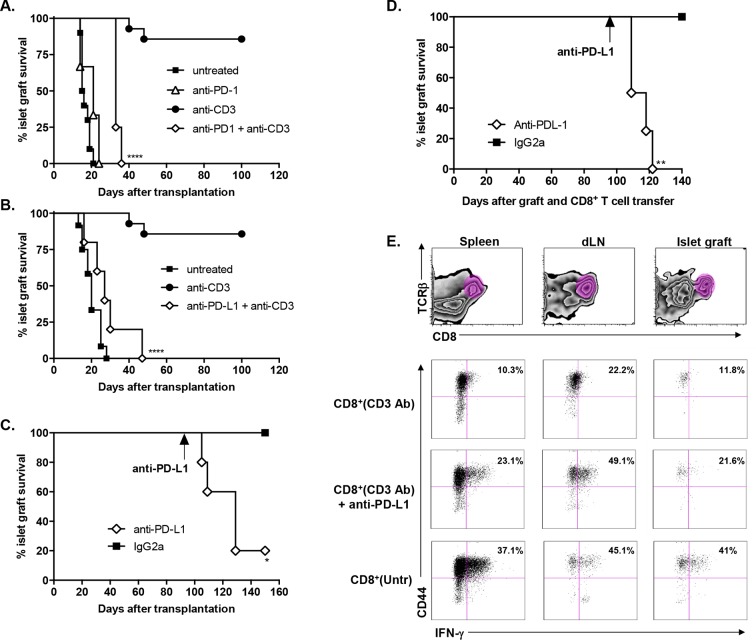
Transplant tolerance and CD8+ T cell anergy rely on the PD-1/PDL-1 pathway.Graft survival of BALB/c islets was measured in C57BL/6 mice treated at day 7 with a combination of anti-CD3 F(ab’)2 and neutralizing antibodies against PD-1 (panel A, n = 5) or PD-L1 (panel B, n = 5) injected at the dose of 500 μg i.p. every other day for a total of 5 injections. (****p<0.0001 between anti-CD3 and anti-CD3+anti-PD-1/anti-PD-L1 Ab-treated mice). (C) C57BL/6 mice showing long-term islet graft acceptance after CD3 Ab therapy were treated on day +100 post-transplant with anti-PD-L1 antibodies or isotype control IgG2a (n = 5). Graft rejection occurred 2–3 weeks later (*p<0.03). (D) CD8+ T lymphocytes were purified from the spleen of CD3 Ab-treated tolerant C57BL/6 mice and were transferred into C57BL/6 Rag-/- mice (3x106/recipient). Recipient mice were grafted with pancreatic islets from BALB/c on day 0 and graft survival was monitored. On day +100 post-transplant, anti-PD-L1 antibodies or isotype control IgG2a were injected (n = 5) (**p<0.007). (E) Tolerant CD8+ T cells were detected in the spleen, draining lymph nodes and islet allograft of C57BL/6 Rag-/- recipients. IFNγ production and CD44 expression were compared to the ones of CD8+ T cells recovered after treatment with anti-PD-L1 antibodies or of CD8+ T cells issued from untreated C57BL-6 mice and rejecting the islet graft.